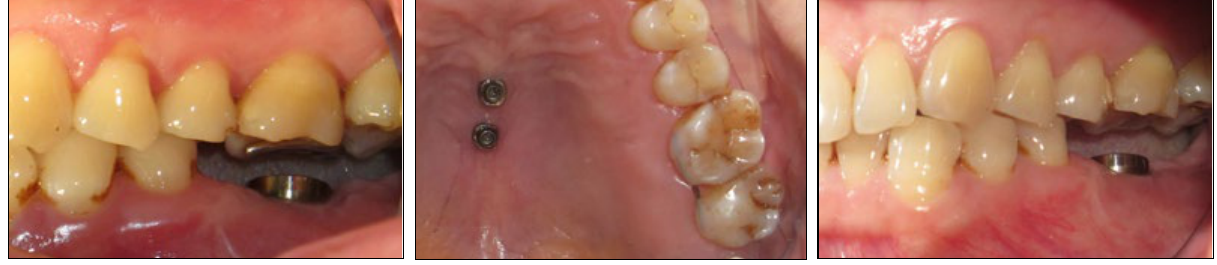
Figure 11. Both upper left molars are corrected.